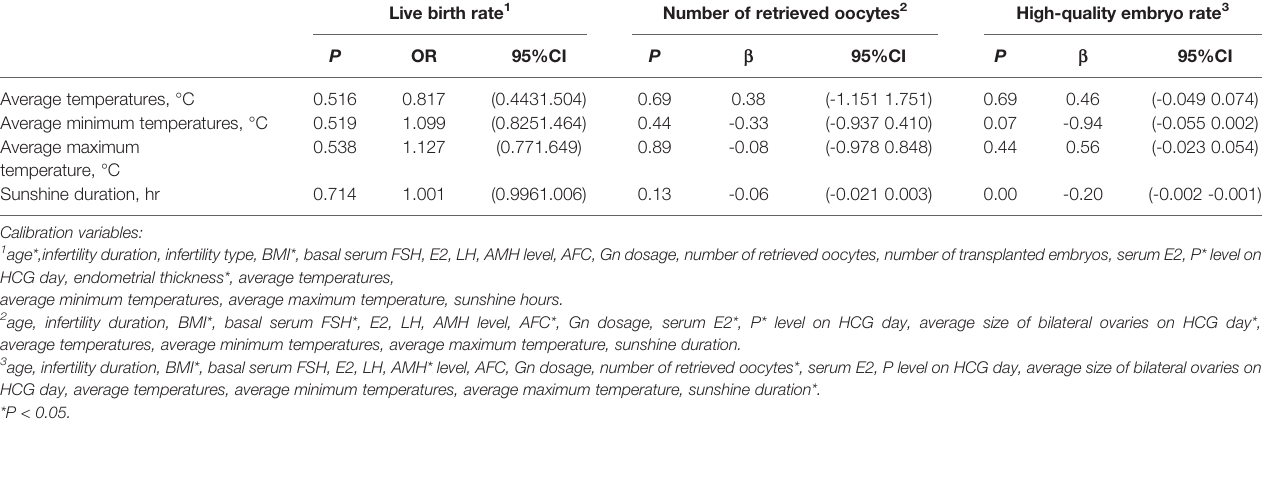
TABLE 3 | Association of live birth rate, number of retrieved oocytes, and high-quality embryo rate with meteorological factors. Live birth rate 1 Number of retrieved oocytes 2